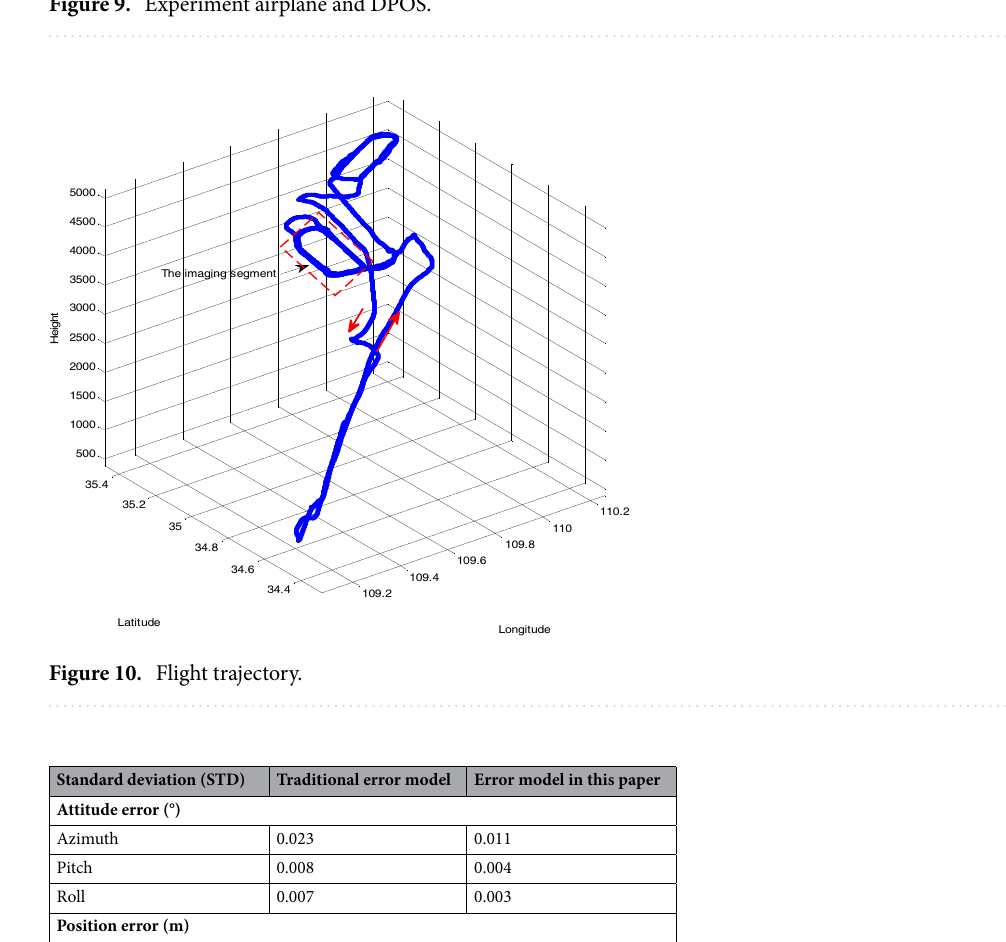
Figure 9. Experiment airplane and DPOS.